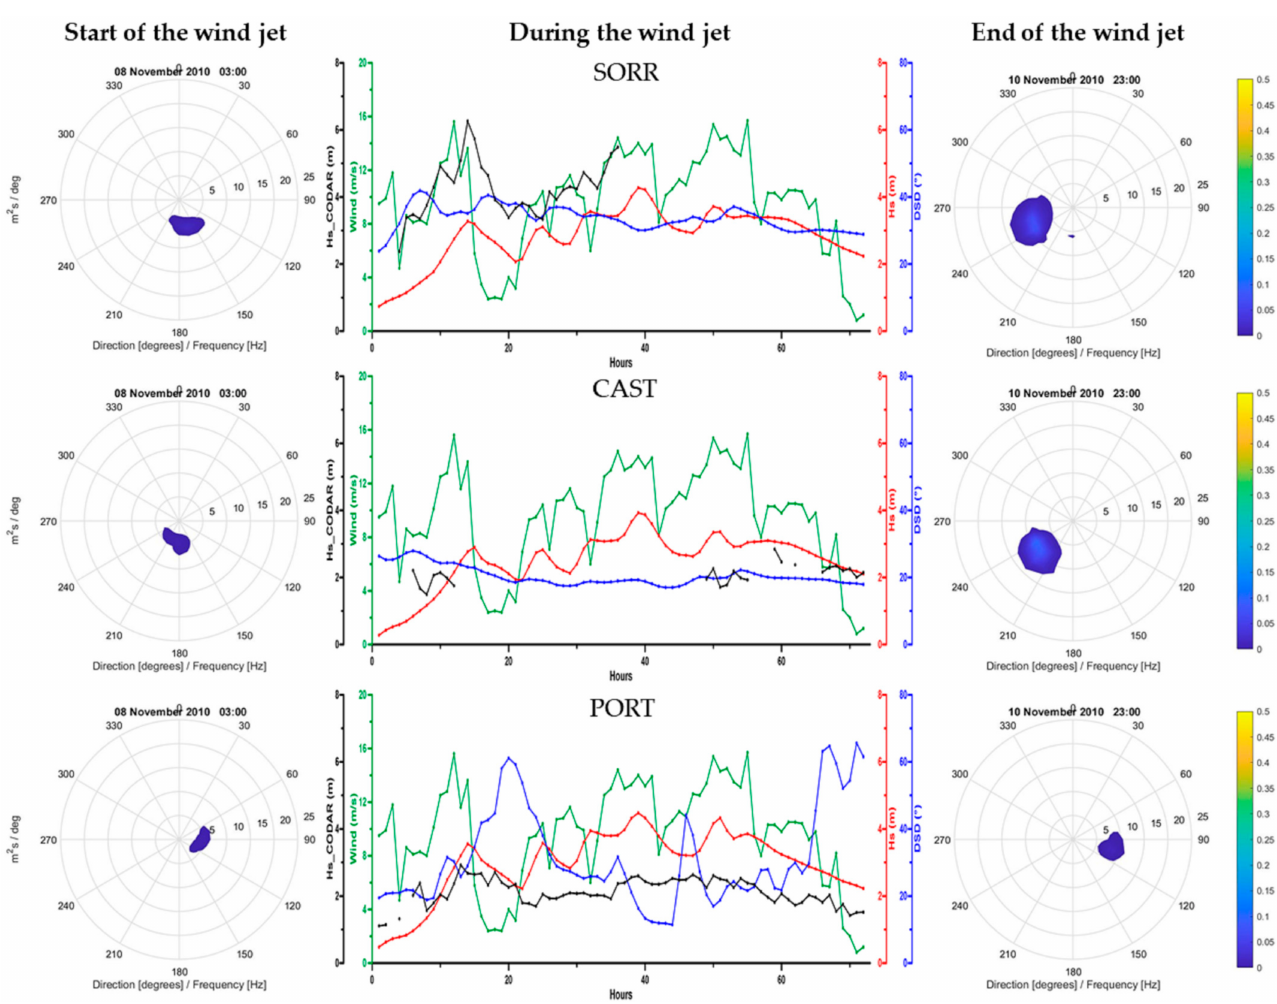
Figure 8. Evolution of storm event (November 2010). First and third panels show the model spectral energy at the wind jet starts and finishes, respectively. The central panels illustrate the evolution, during the event, of the wind intensity (in green), significant wave height (of the model (in red) and retrieved by the HFr Hs HF (in black)) and the directional spreading DSD